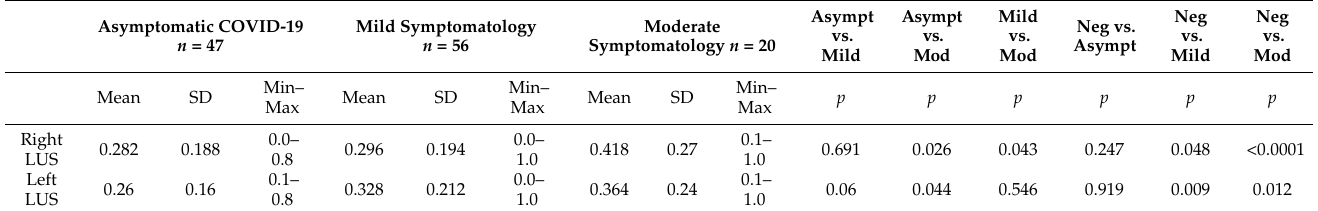
Table A2. Data of patients who experienced COVID-19 sorted by symptoms in left and right lung.